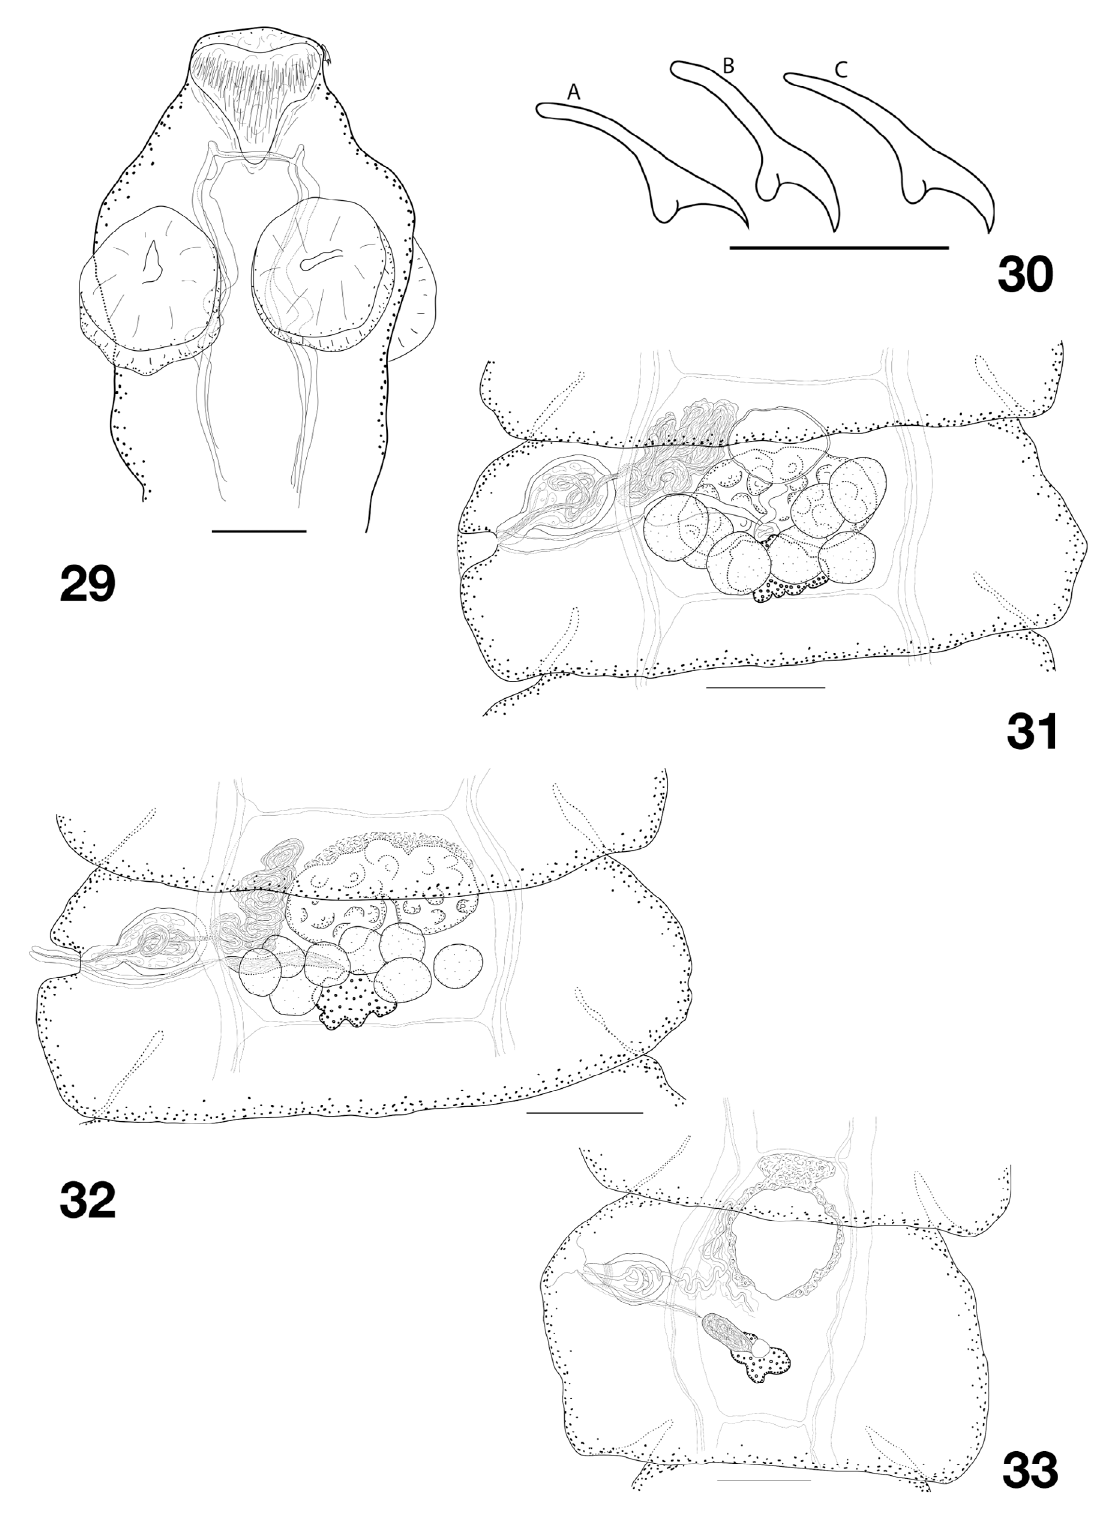
Figs 29–33. Notopentorchis musealis sp. nov. 29 . Scolex. 30 . Hooks: A, C. Anterior hooks, B. Posterior hook. 31 . Mature proglottis. 32 . Postmature proglottis. 33 . Pregravid proglottis. Scale bars: 29, 31–33 = 100 µm; 30 = 20